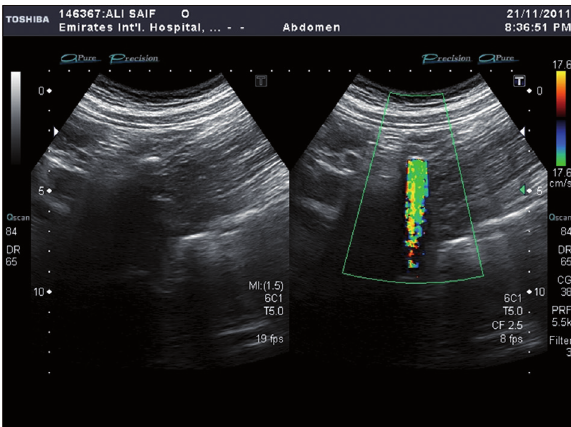
Figure 1B - Middle ureteral stone after application of color Doppler ultrasound with